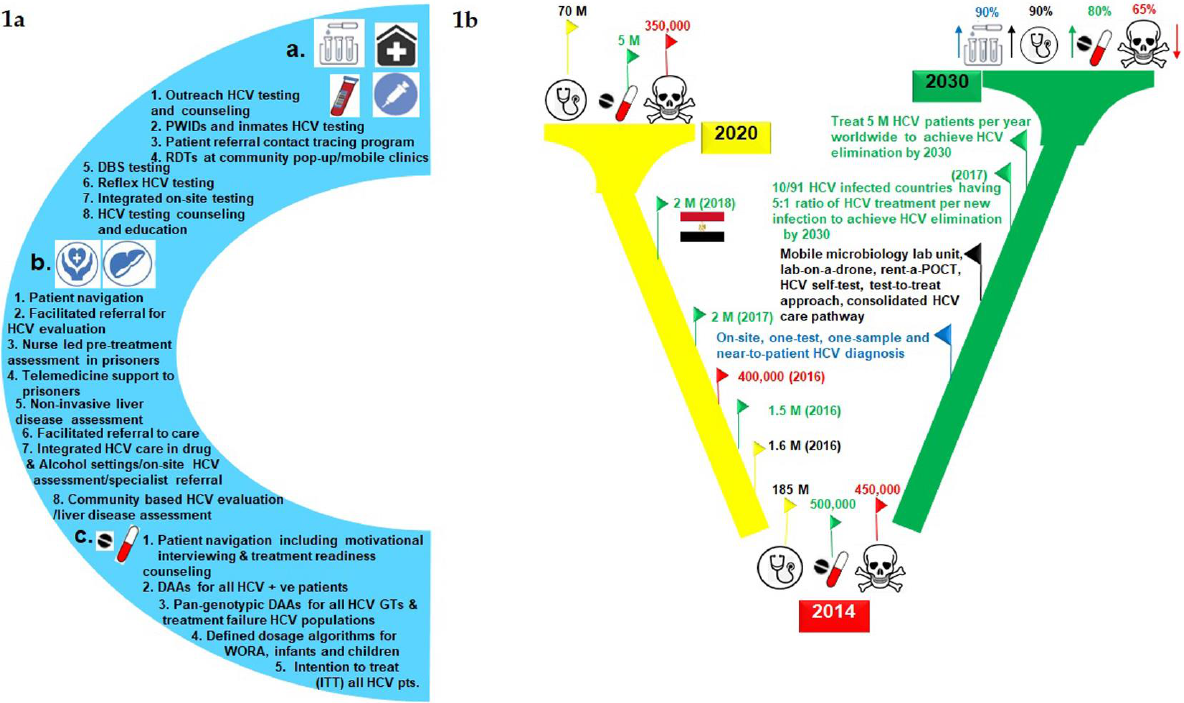
Figure 1. HCV care cascade strategies and WHO goals of HCV elimination by 2030. ( 1a ) represents HCV cure pathway strategies, policies, and procedures at diagnostic (depicted in Figure 1a as ‘ a ’), linkage to care (depicted in fig 1a as ‘ b ’), and treatment uptake levels (depicted in fig 1a as ‘ c ’). The diagnostic approaches, treatment choices, and measures to be taken, which one seems feasible to make rapid progress toward elimination goals for hepatitis C by 2030, and what should be the key focus are mentioned under each category. ( 1b ) represents the comparison of HCV diagnosis, treatment uptake, and mortality before the DAAs era, HCV elimination goals achieved until 2020, and the targets for the next 10 years re- garding HCV elimination efforts. The base of the symbolic letter, ‘V’, demonstrates how many people were infected, di- agnosed, and died by HCV infection and associated hepatic co-morbidities in 2014 before the inclusion of all oral inter- feron-free DAAs to be administered for HCV treatment. The yellow pedestal of the letter ‘V’ indicates the achieved goals in respect to hepatitis C elimination by 2020 compared to the intermediary set goals of WHO for this period in 2016 (i.e., 30% decrease in new HCV incidences and 10% reduction in mortality). Green flags indicate the treatment uptake and cure of HCV patients with DAAs onward from 2014. Red flags indicate the decrease in mortality rate after treatment recom- mendation with DAAs onward from 2014. Yellow flags indicate an escalation of HCV diagnosis after advancing the screen- ing and diagnostic procedures as well as initiating mass HCV screening campaigns. The green pedestal of the letter ‘V’ indicates the priorities to set, policies to design, strategies to implement, and considerable work to do enabling the world to eliminate hepatitis C as a major public health threat before, by, or beyond 2030. The blue flag indicates an urgent need for one-test, one-step, and one visit HCV diagnostic to achieve WHO goals of HCV testing and infection diagnosis (i.e., 90%) by 2030. The black flag indicates novel testing approaches and treatment models to implement while escalating HCV diagnosis and linkage to care in remote areas as well as in vulnerable HCV populations. The green flags depict that how many countries are on track to achieve the set goal of HCV elimination by 2030 and how many patients to be treated with pan-genotypic DAAs to enhance HCV treatment by 80% and 65% reduction in mortality. = central lab, = phlebotomy, = sample, = testing, = hepatic disease assessment, = diagnosis, = treatment, = linkage to care, = mortality, = Egypt. PWIDs = Patients who inject drugs, RDT = rapid diagnostic test, DBS = dried blood spot, DAAs = direct-acting antivirals, GT = genotyping, WORA = women of reproductive age, POCT = point-of-care testing.